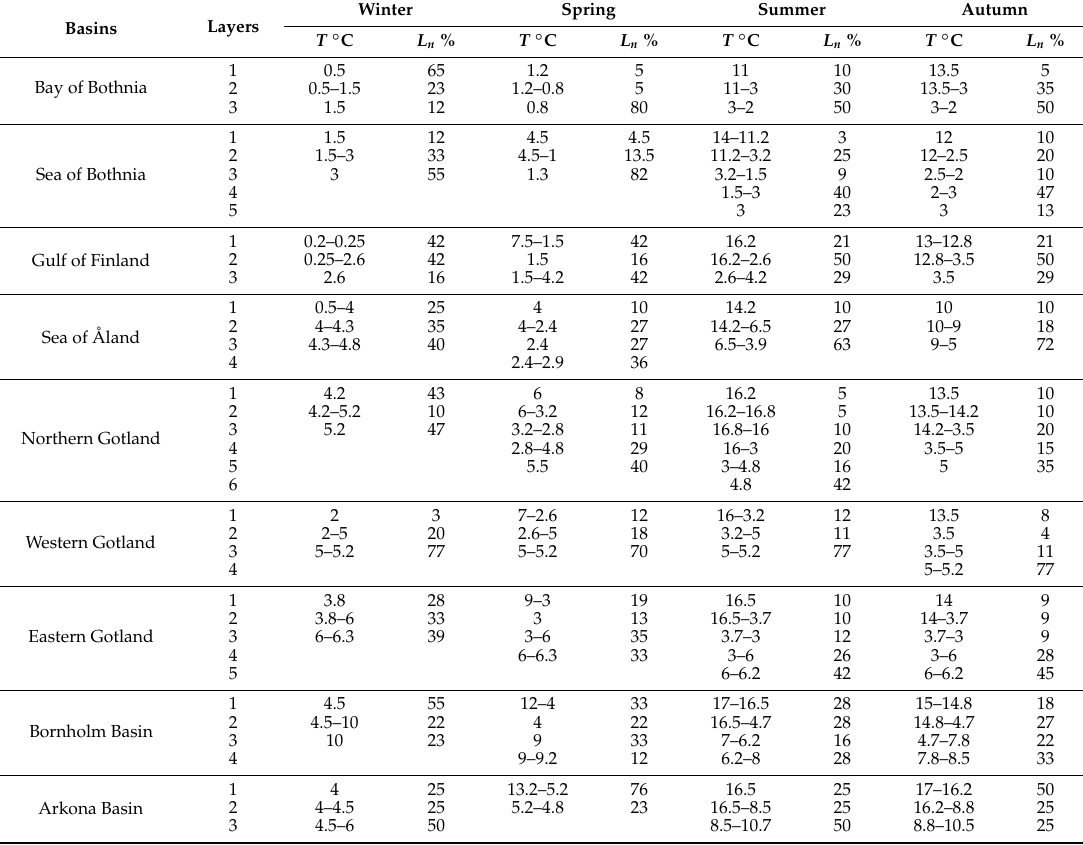
Table 2. Characteristics of thermal stratification in the basin system of the Baltic Sea, 2000–2009.